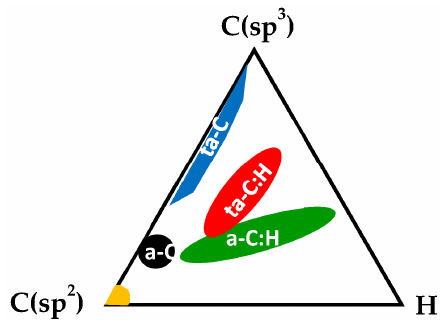
Figure 21. Basic ternary phase diagram of amorphous carbons.